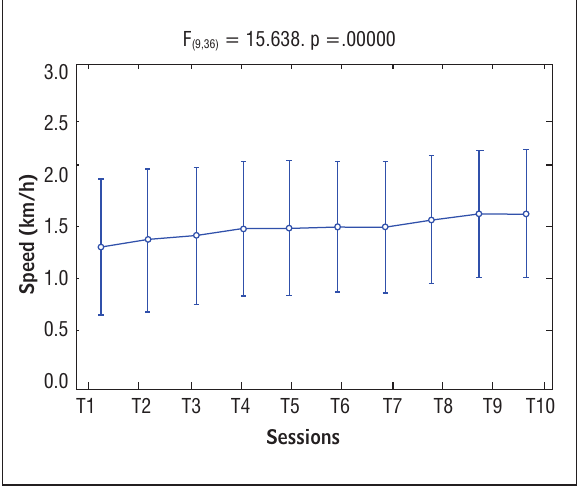
Figure 3 - Mean and confidence intervals of walking speed (in km/h) over the course of the 10 sessions